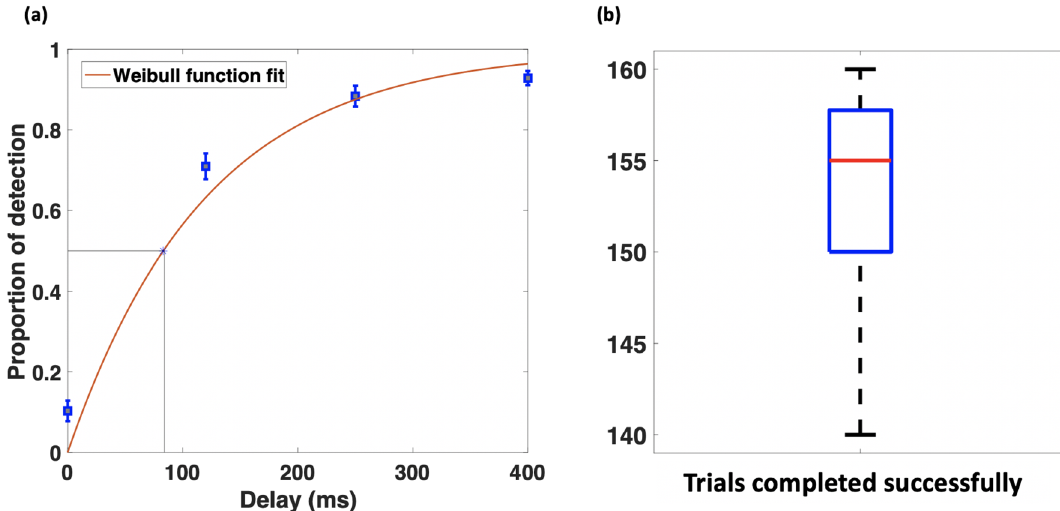
Figure 3. ( a ) The proportion of detected trials per condition are plotted and fit to a Weibull function forming a psychometric function for the haptic delay. The 50% detection threshold is estimated and marked to be around 85 ms. Error bars represent the standard error of the mean. ( b ) Boxplot showing the trials completed successfully by participants. A successful trial is identified by placing the object inside the